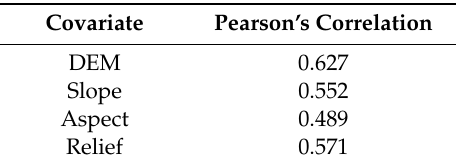
Table 3. The Pearson’s correlation table of field SM data and the selected four terrain variables (2019 March